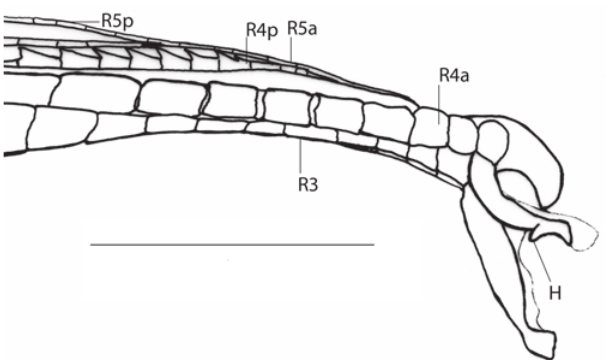
Fig. 45. Gonopodium tip of Phalloceros anisophallos , MCP 12603. R3, R4a, R4p, R5a, R5p indicate gonopodial rays. Scale bar 1